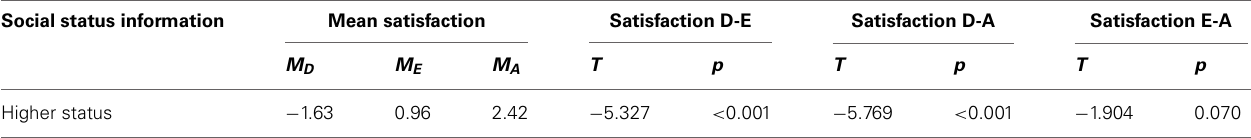
Table A1 | Mean satisfaction ratings and p -values in high status group (i.e., Subjects face lower status only). Social status information